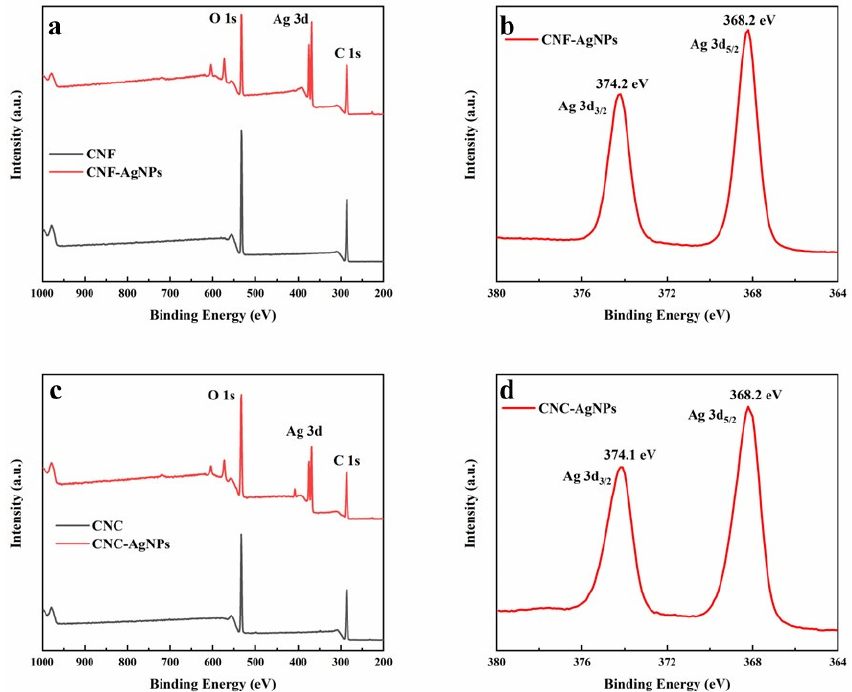
Figure 4. XPS spectra of nanocellulose and NC-AgNPs. ( a ) XPS spectra of CNF and CNF-AgNPs, ( b ) XPS spectrum of Ag 3d of CNF-AgNPs, ( c ) XPS spectra of CNC and CNC-AgNPs, ( d ) XPS spectrum of Ag 3d of CNC-AgNPs.